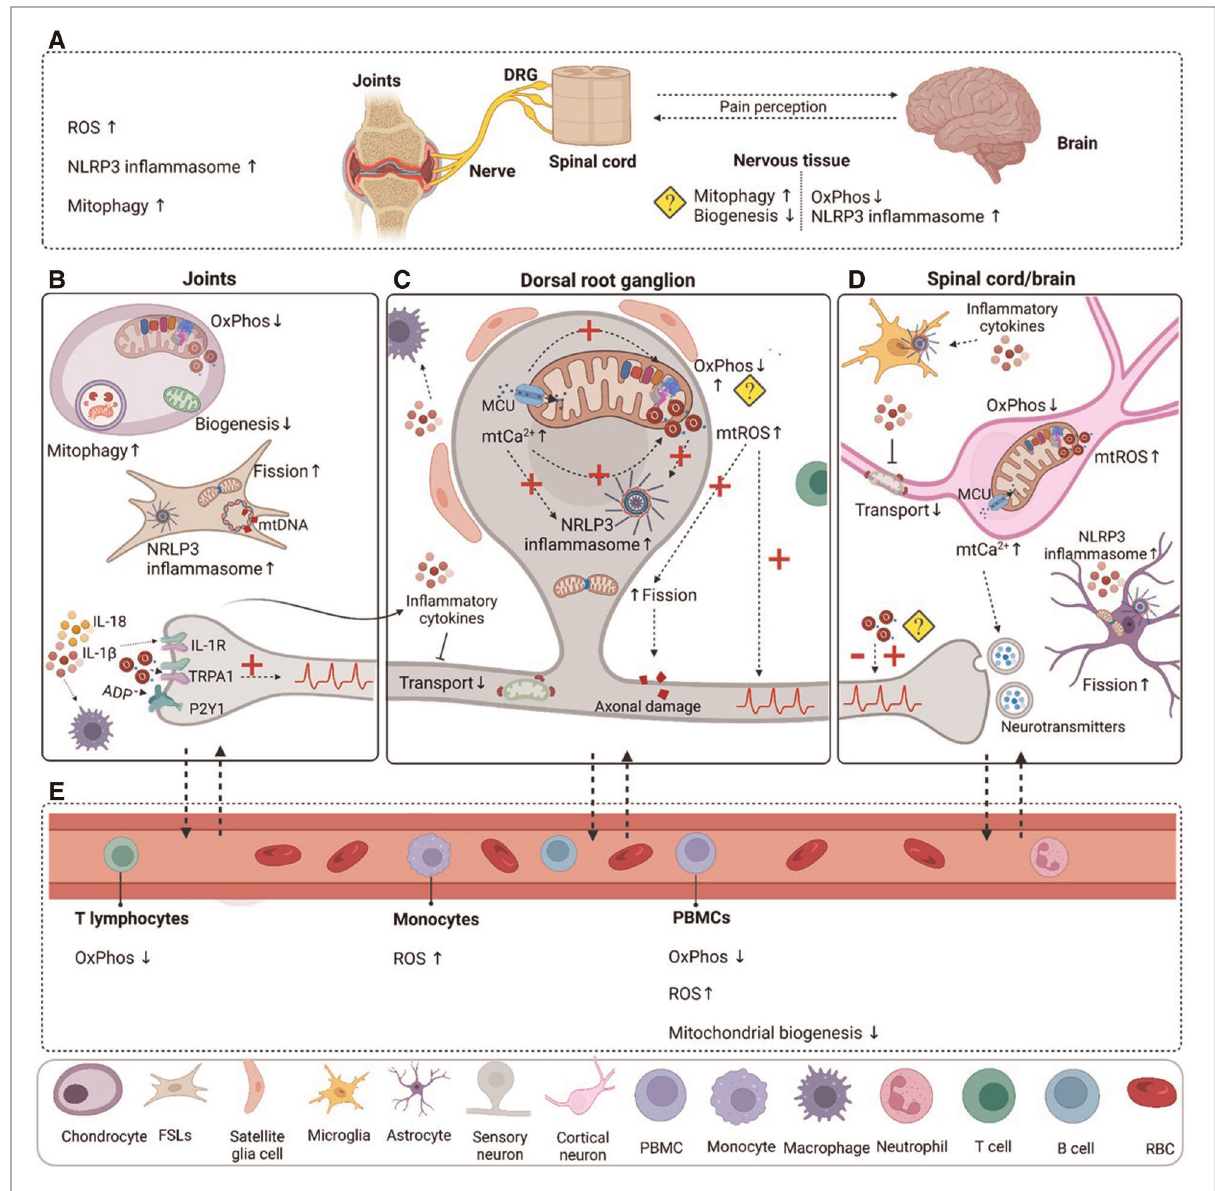
FIGURE 2 Mitochondrial dysfunction in rheumatic pain conditions. ( A ) Oxidative stress, NLRP3 in fl ammasome activation and mitophagy are increased in the joint in various rheumatic conditions. Mitochondrial dysfunction is not limited to the damaged joint tissue; it is also present in the nervous system. Decreased mitochondrial respiration and increased in fl ammasome activation have been detected in RA animal models. Indirect evidence points to decreased mitochondrial biogenesis and excessive mitophagy in the nervous system, but it is not clear in which cells. ( B ) Evidence from clinical and pre-clinical studies points to impaired mitochondrial functions in chondrocytes and fi broblast-like synoviocytes (FLSs), which could contribute to the in fl ammatory milieu observed in the joint and may activate resident immune cells like macrophages. Mutations in mtDNA may contribute to impaired mitochondrial function. Peripheral in fl ammation and damage activate and induce long-lasting changes in sensory neurons, and increase their excitability. ( C ) Sensory neuron activation increases mitochondrial Ca 2+ levels that promote OxPhos, but also mtROS production. Continuous mtROS production may impair mitochondrial respiration or cause mtDNA mutations. In fl ammation and oxidative stress reduce mitochondrial transport and impair quality control mechanisms (mitophagy, mitochondrial biogenesis, fusion and fi ssion). Disturbed mitochondrial Ca 2+ buffering and mtROS trigger NLRP3 in fl ammasome activation in neurons. ( D ) Prolonged activation of nociceptors in the periphery affects the spinal cord/brain axis of pain processing and can induce permanent central changes in neuroplasticity and mitochondrial dysfunction in neurons and supporting cells like astrocytes. ( E ) Changes in mitochondrial functions in blood components and cells appear to be present in patients with various rheumatic diseases. Even if these alterations were not directly linked to pain, they could shed some light on how mitochondria are affected in rheumatic disease. A question mark is used when there is indirect evidence or there are contradictory fi ndings. Dashed arrows were used to represent hypothetical connections or consequences that have not been directly linked to rheumatic pain. DRG, dorsal root ganglia; PBMC, peripheral blood cells; RBC, red blood cell. Figure created with